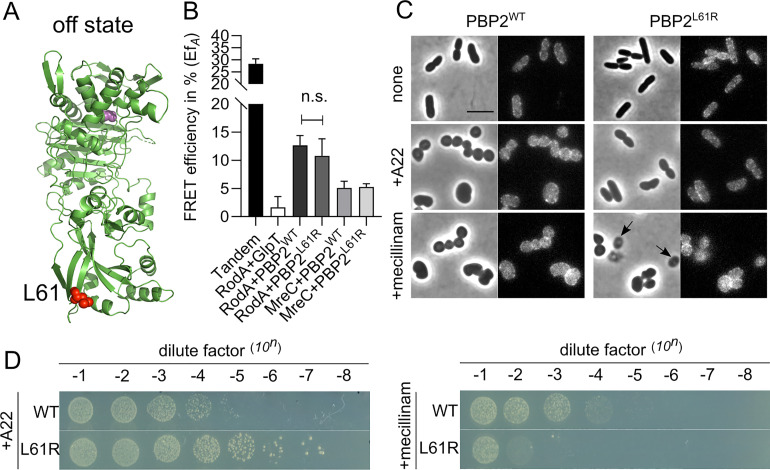
Hyperactive mutant PBP2L61R is more sensitive to mecillinam.a. Modeled “off state” structure of E. coli PBP2 from H. pylori PBP2 using Phyre 2. Structural information lacks on the juxta-membrane, transmembrane helix and cytoplasmic regions of PBP2. Residue Leu61 is colored in red and shown as spheres. Active site Ser330 is colored in pink and shown as spheres. b. Hyperactive mutant PBP2L61R interacts similar like PBP2WT with RodA and MreC. RodA and MreC were fused with mCherry, and PBP2WT and PBP2L61R were fused with mKO. c. Phase contrast and fluorescence images of cells expressing PBP2L61R were less sensitive to A22 but hypersensitive to mecillinam in liquid culture. LMC500 strain expressing nothing, or PBP2WT, or PBP2L61R were grown in LB medium at 37°C. IPTG induction (15 μM), and A22 treatment (10 mg·L-1) or mecillinam treatment (2 mg·L-1) were applied to each culture for 2 mass doublings. Arrows indicate cells that lysed after mecillinam treatment in the PBP2L61R culture. Scale bar equals 5 μm. d. Spot assay to test the sensitivities of PBP2WT and PBP2L61R to A22 (10 mg·L-1) and mecillinam (2 mg·L-1).